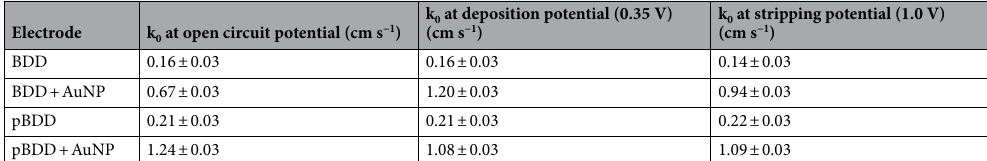
Table 3. The electron transfer rates of each of the electrodes tested at 1 pM mercury concentration, calculated from the parameters extracted from equivalent circuit modelling fits of the raw EIS data (see Supplementary